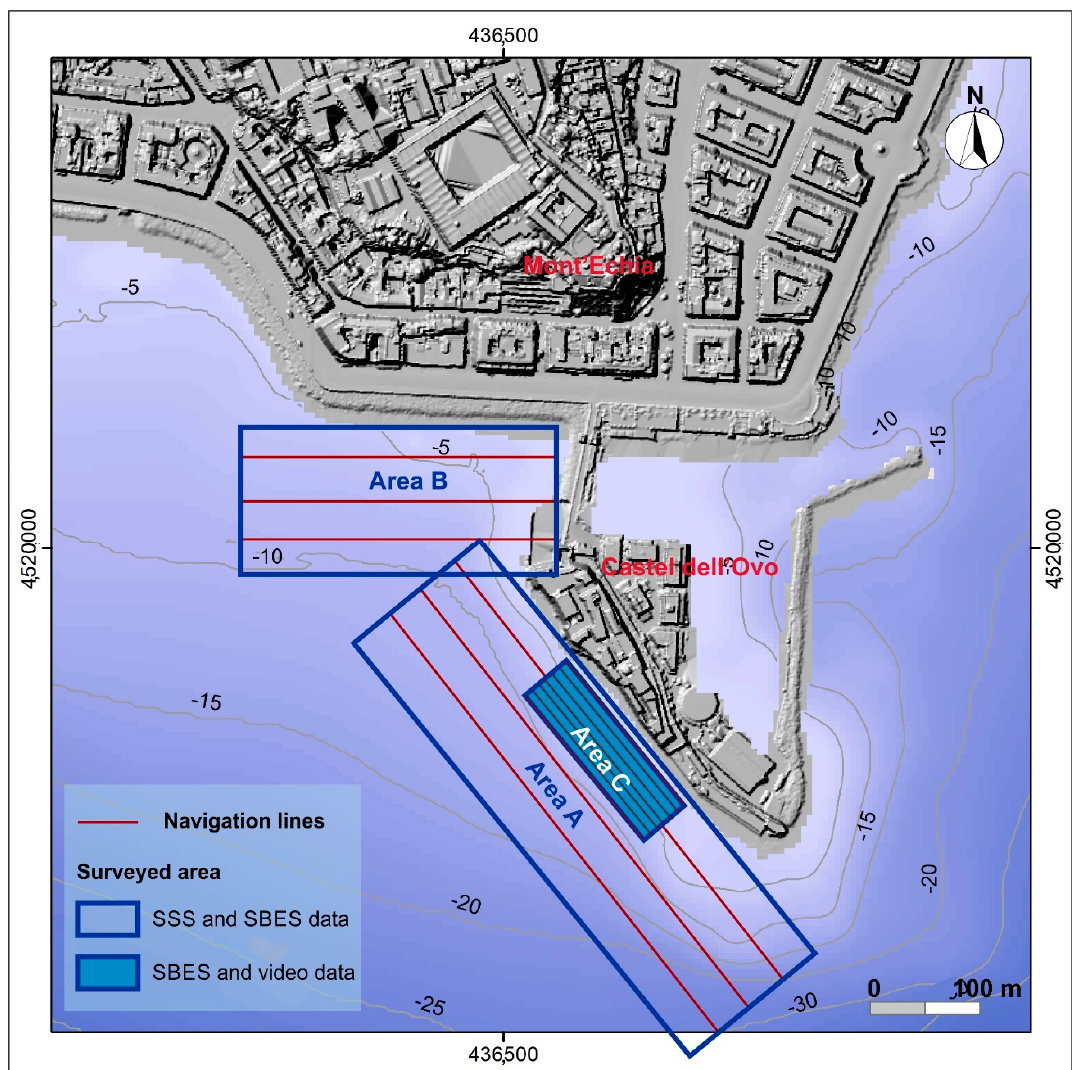
Figure 6. Map of the navigation carried out during the indirect survey. The shaded relief in the figure has been calculated from the digital surface model (DSM, with a grid 1 × 1 m), provided by the Municipality of Naples.